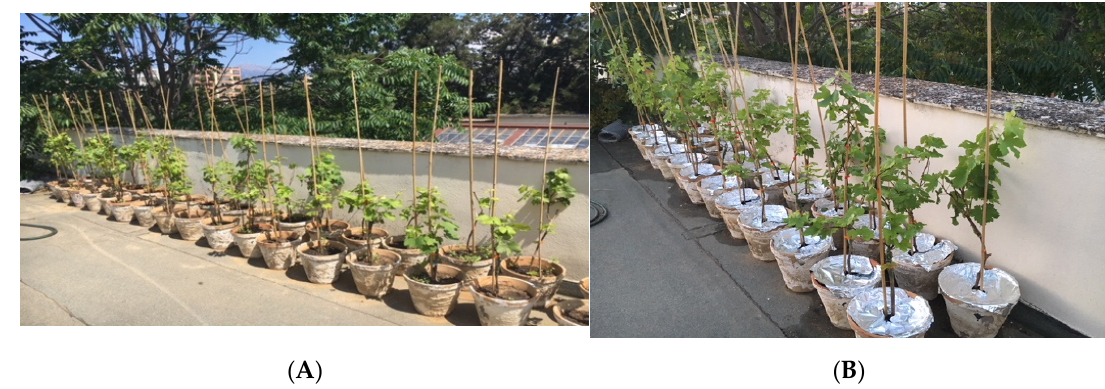
Figure 1. Experimental randomized block in clay pots filled with a sand: peat mixture at the open area near the EMBIA Laboratory. ( A ) V. vinifera plants before inoculation and ( B ) V. vinifera plants after inoculation.